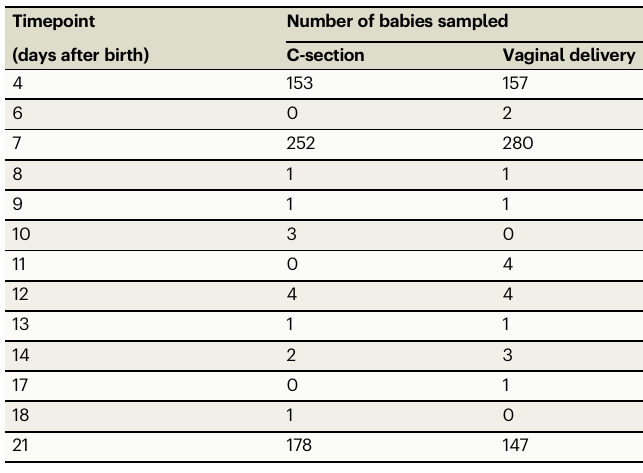
Table 1 | Number of babies sampled at each timepoint during the fi rst month of life Timepoint